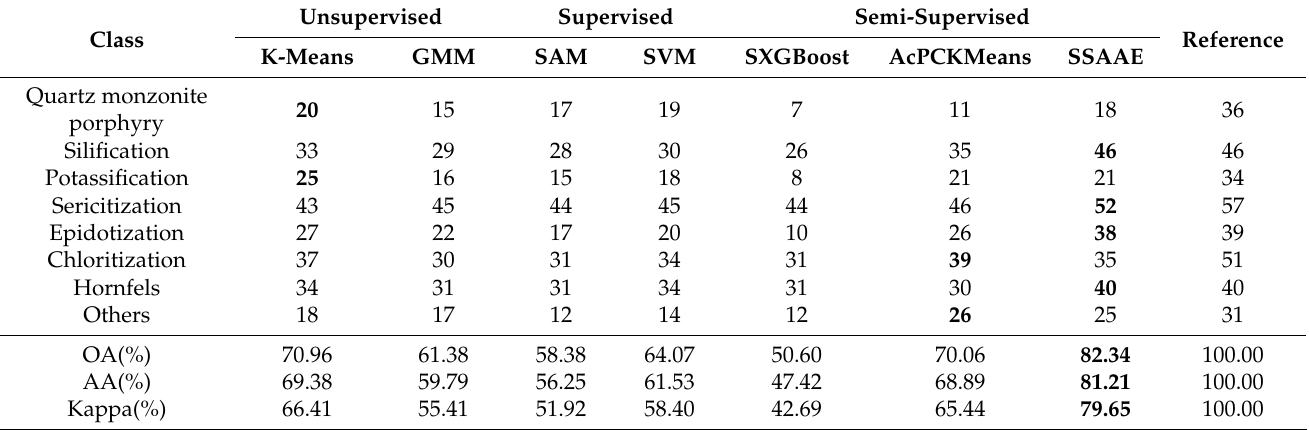
Table 5. Comparison of alteration type classification results using different methods on the measured hyperspectral